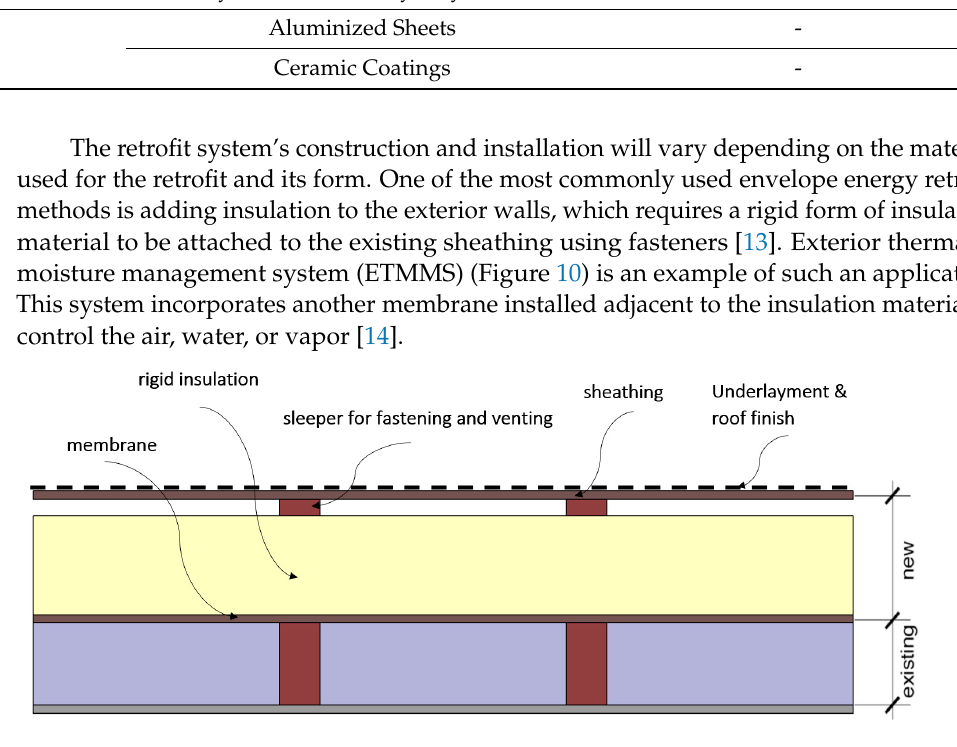
Figure 10. Exterior thermal & moisture management system (ETMMS) details for roof overcoat (adopted from [14]).